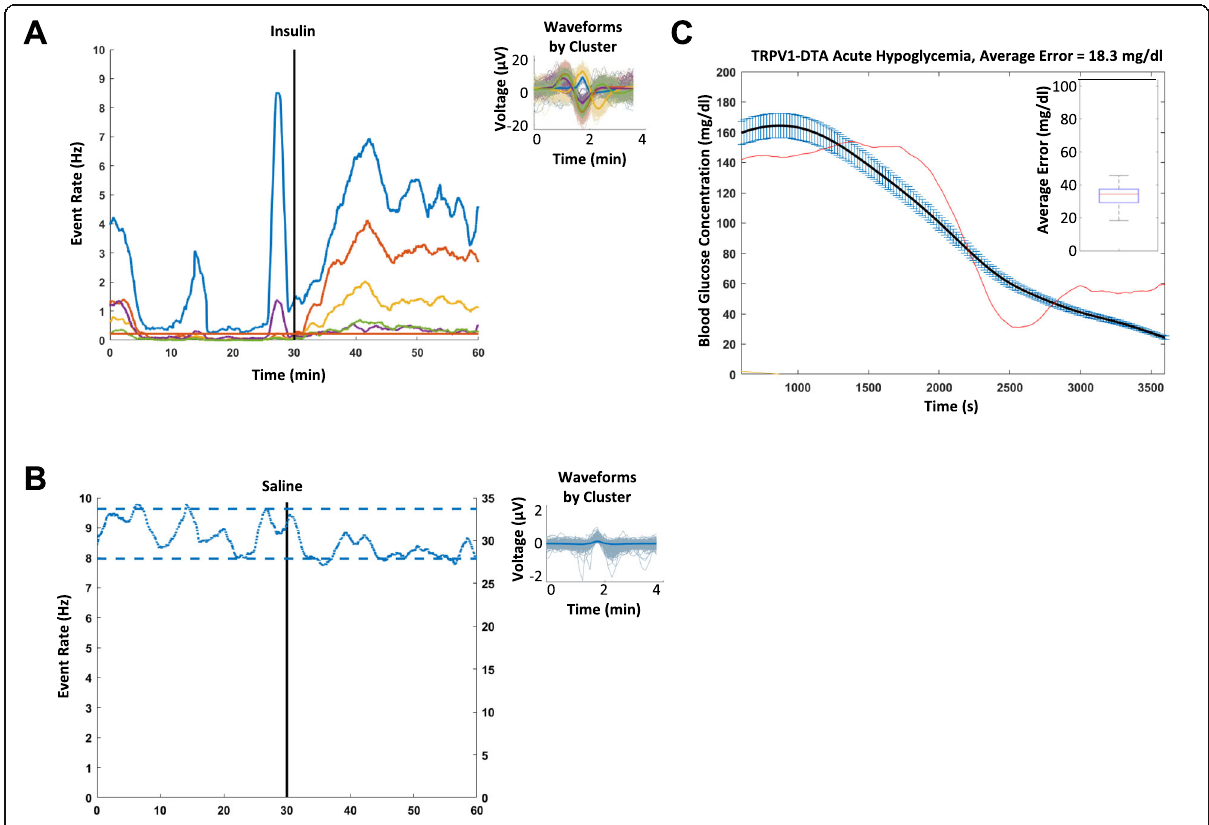
Fig. 5 Indicative neural responses to different injections from TRPV1+ Cell-depleted mice. Each colored trace represents the response rate against time of a different CAP – solid lines correspond to lower firing rate CAPs (maximum of 10 CAPs/sec) and dotted lines corresponds to high firing rate CAPs (maximum of 30 – 50 CAPs/sec). The injection is indicated by a vertical black line occurring at 30 min. The thresholds encapsulating the baseline statistics of a particular CAP are indicated by horizontal lines of the same color. An example of the a insulin VN response curves, along with their respective CAP waveforms, and b an example of the neural response to the saline injection control, where there is no discernible response to the injection, along with the respective CAP waveform. An example of TRPV1+ Cell-depleted mice c regression model performance from an insulin injection. The black line indicates the smoothed blood glucose measurements, with blue bars indicating measurement error. The red line indicates the estimated blood glucose levels as an output of the regression model. The regression somewhat traces the smoothed blood glucose measurements, and the average error over the N = 7 subjects has an interquartile range between 29 and 37